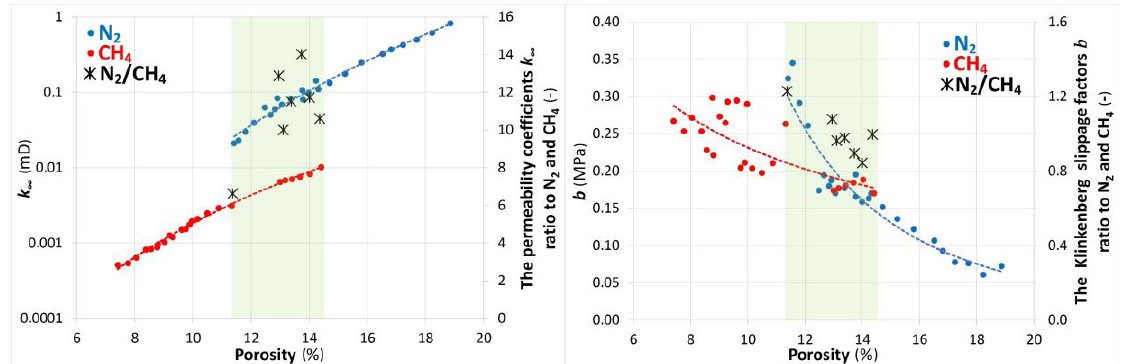
Figure 9. The relationship between the values of the Klinkenberg permeability coefficient k ∞ , and the slippage factor b of coal briquettes and nitrogen & methane as a function of porosity.